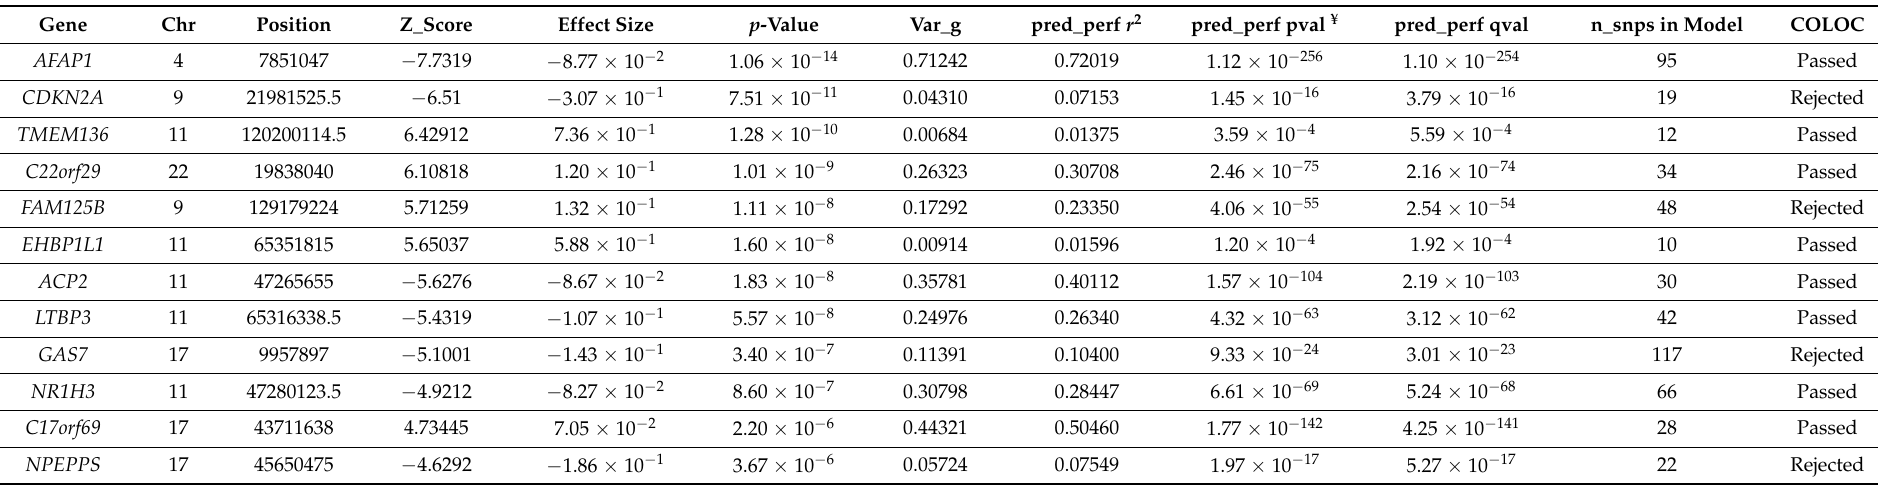
Table 3. Significant MetaXcan results of POAG analysis using the DGN whole blood transcriptome model.